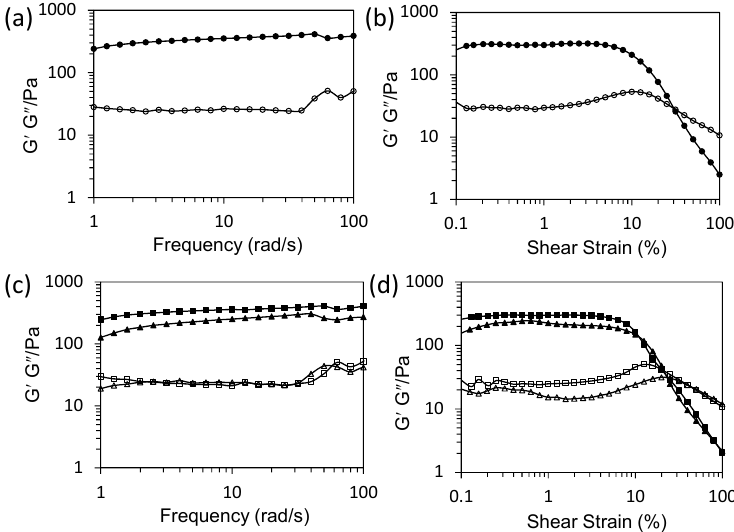
Figure 2. Rheometry studies showing ( a ) frequency sweep and ( b ) amplitude sweep curves for an as-prepared CNC–organoclay colloidal nanocomposite hydrogel (ratio 1:0.13); values for storage G ′ (filled circles) and loss G ″ moduli (open circles); ( c ) and ( d ) show frequency and amplitude sweep profiles, respectively, for a CNC–organoclay nanocomposite hydrogel (ratio 1:0.13) after exposure to gaseous ammonia ( G ′ , filled triangles; G ″ , open triangles) and carbon dioxide ( G ′ , filled squares; G ″ , open squares).